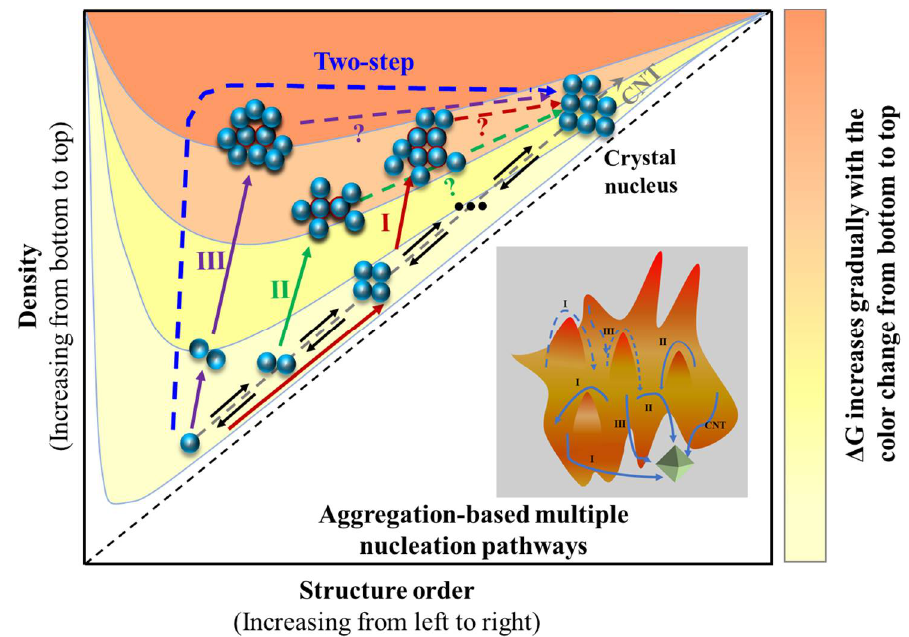
Figure 10. Schematic illustration of molecular aggregation-based multiple nucleation pathways: various pathways of evolutions of density and structure order of solutes’ associates, aggregates, or clusters accompanying the change of free energy in different solution systems. Pathway I represents the self-assembly and nucleation pathway of benzoic acid molecules in toluene; pathway II denotes the scenario of crystal nucleation of TFA in toluene, and pathway III is the case of gly in water and other systems wherein (solvated) monomers are dominant in solution. The blue dashed line is the pathway of two-step nucleation. The light grey dash line represents the nucleation pathway of CNT.